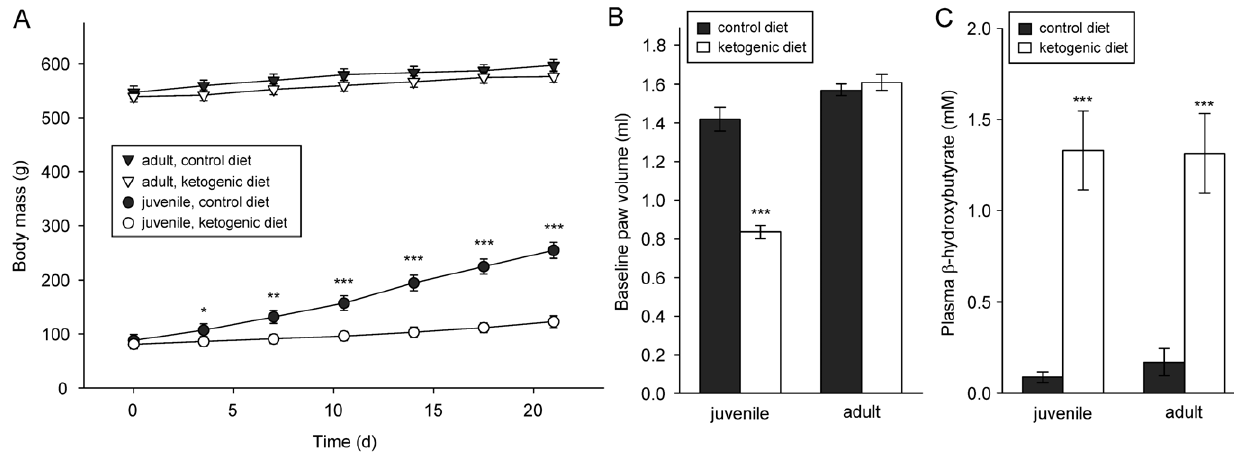
Figure 4. The ketogenic diet retards growth in juvenile but not adult rats, while inducing equivalent ketosis. A: All groups gained weight over three weeks. There was no difference in weight gain between diet groups in the adult animals; juvenile animals on the ketogenic diet gained weight significantly more slowly than those on the control diet. Analysis of juveniles revealed significant effects of time (F=635.1, p , 0.001) and diet (F=17.6, p , 0.001), as well as a significant time x diet interaction (F=241.8, p , 0.001), whereas for adults, there was a significant effect of time (F=62.7, p , 0.001) but not diet (F=1.2, n.s.) and no significant interaction (F=1.2, n.s.). Numbers of subjects: 12 for each juvenile group, 14 for adult control diet, 16 for adult ketogenic diet. B: Like body weight, baseline paw size (before CFA injection) was lower with the ketogenic diet in juveniles but not in adults. Numbers of subjects as in Fig. 2. C: Plasma levels of the ketone body b -hydroxybutyrate were similarly elevated in juvenile and adult rats. Analysis revealed a significant effect of diet (F=49.6, p , 0.001) but not age (F=0.8, n.s.) and no significant interaction (F=0.8, n.s.). Number of subjects=7–9. *p , 0.05, **p , 0.01, ***p , 0.001 Newman-Keuls (A,C) or t-test (B) comparisons to age-matched controls.